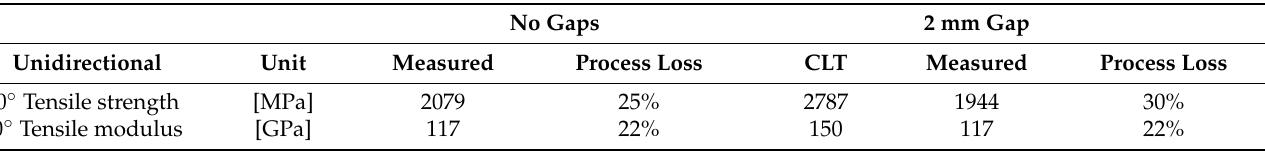
Table 9. Comparison of the measured unidirectional tensile strength and modulus to the theoretical value from the classical laminate theory (CLT).